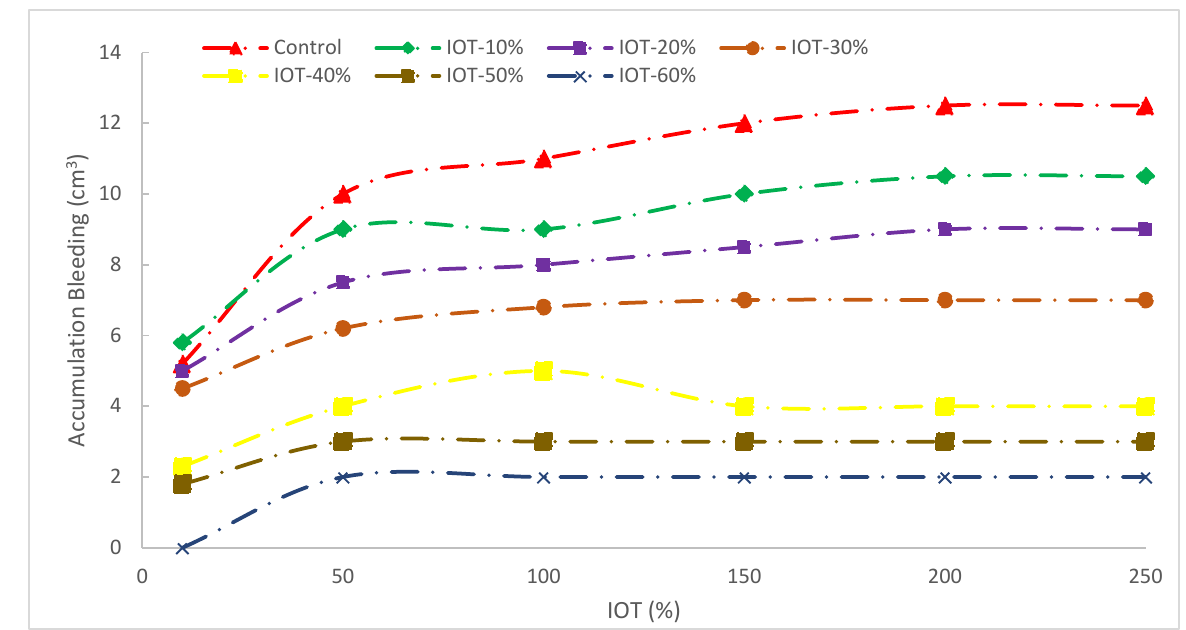
Figure 6. Bleeding of concrete with IOT [50].